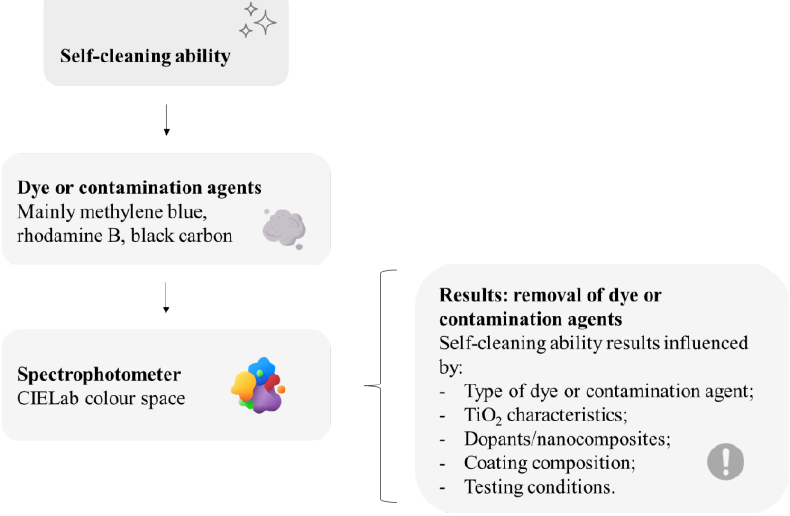
Figure 6. Main recurrent issues reviewed on the self-cleaning evaluation of mortar samples with thin TiO 2 -based coatings. This figure has been designed using resources from Flaticon.com (Creatype, Freepik, Good Ware).